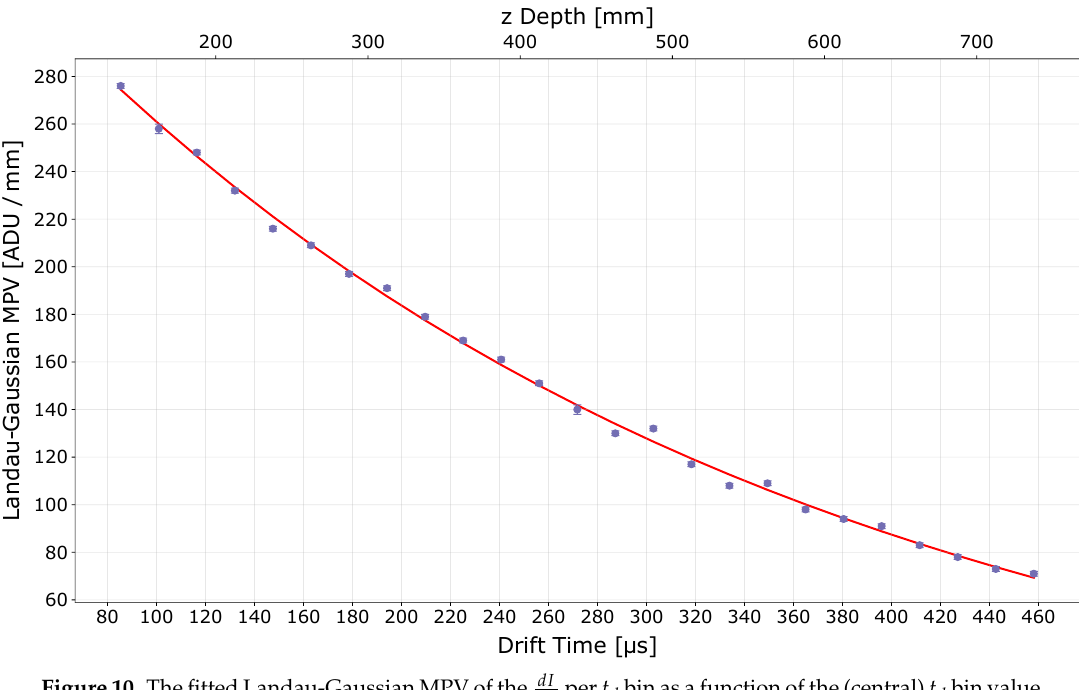
Figure 10. The fitted Landau-Gaussian MPV of the dI per t d bin as a function of the (central) t d bin value dX (bottom x axis). Also indicated (top x axis) is the corresponding z -depth of each t d value. Error bars indicate only the statistical uncertainties. The MPV values have been fitted with an exponential function of the form given by Equation (4) in order to determine the electron